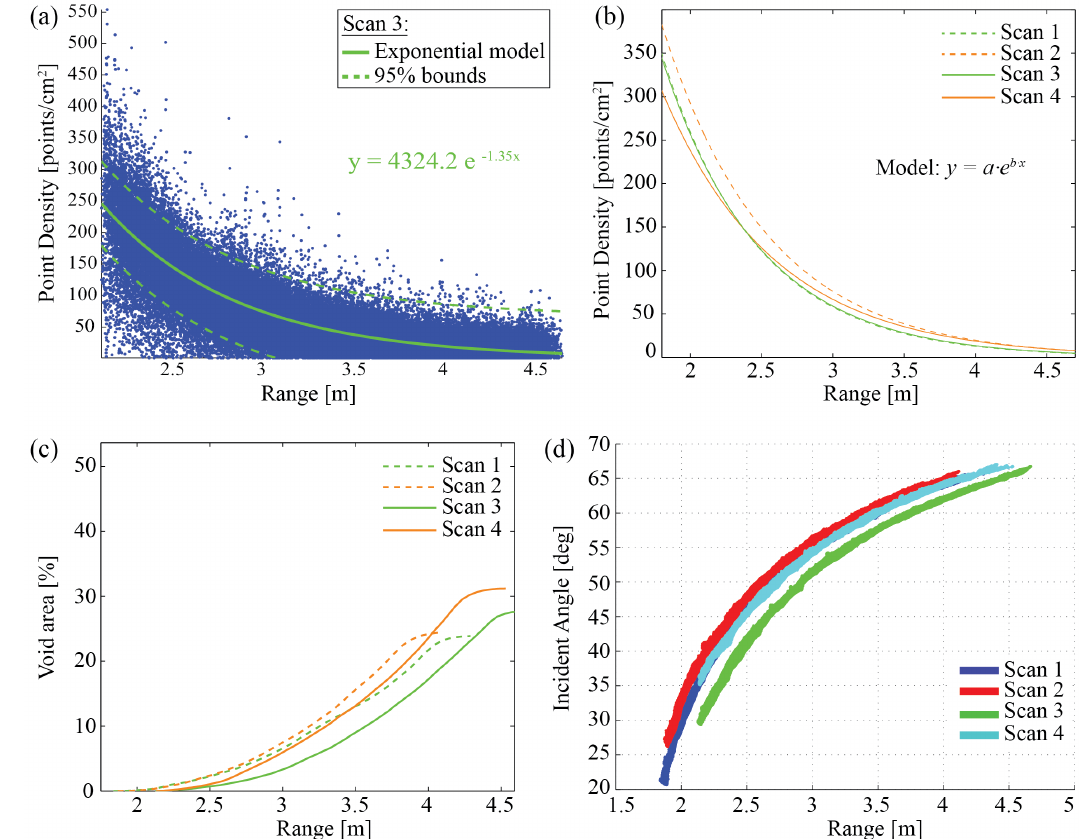
Figure 3. ( a ) Change in point density over the range for the TLS Scan 3. The green line shows the fitted exponential model with its 95% confidence bounds; ( b ) The exponential models of the density drop over the range for the four single TLS scans; ( c ) The percentage of the void area over the range for the single TLS scans; ( d ) The relation between the range and the incidence angle within the plot for the single TLS scans. The incidence angles were calculated with respect to the planar trend of the plot.